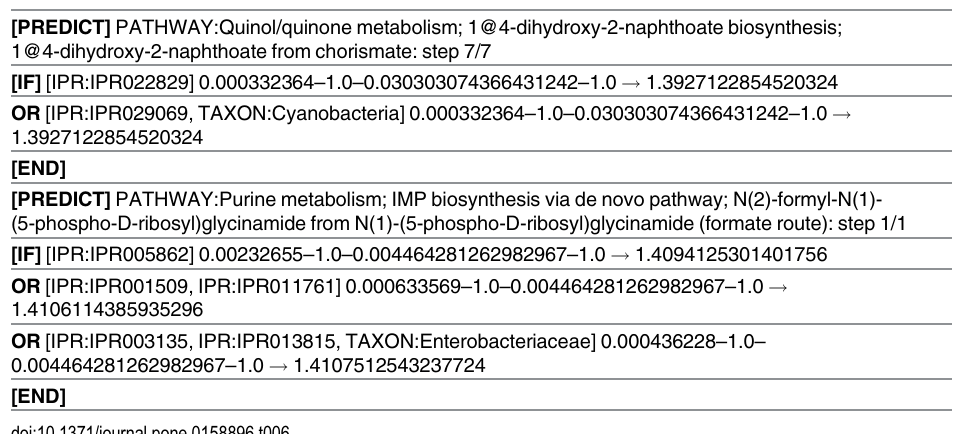
Table 6. Examples of prediction models obtained in the form or aggregated rules along with their eval- uation measures for UniProt/Swiss-Prot prokaryotic entries with manual assertion evidence for path- way annotations. Each rule is accompanied by its four evaluation measures and its Euclidean distance to normalized ideal